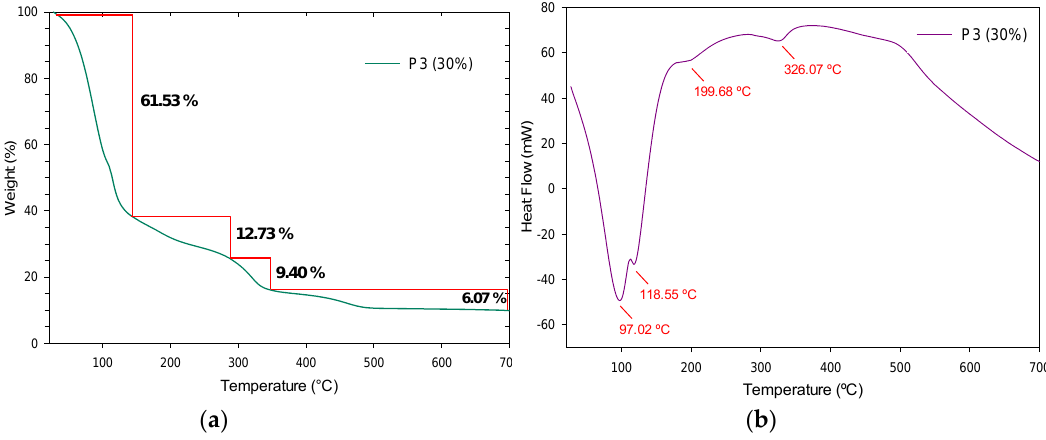
Figure 20. P3 (30%) results: ( a ) TGA analysis and ( b ) DTG thermogram.